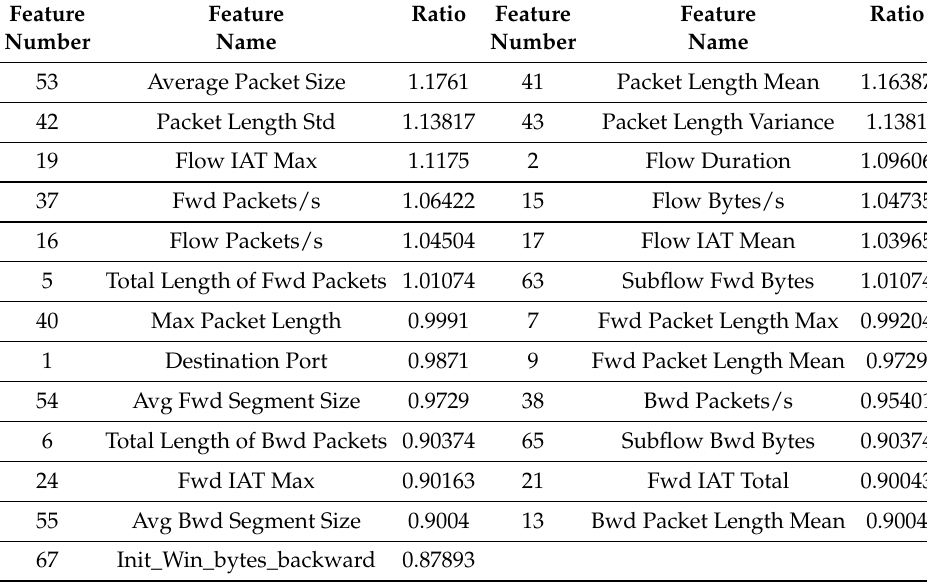
Table 4. Information gain ratio for different features on CICIDS2017